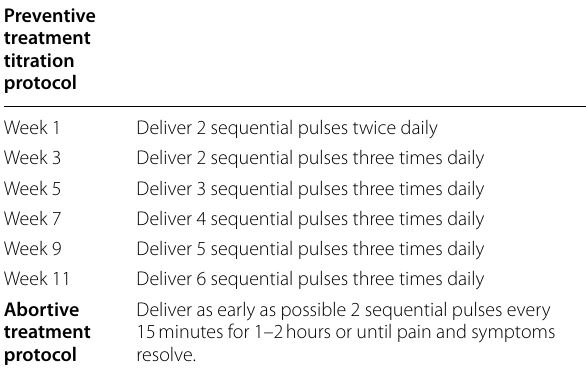
Table 1 Single‑pulse transcranial magnetic stimulation device treatment